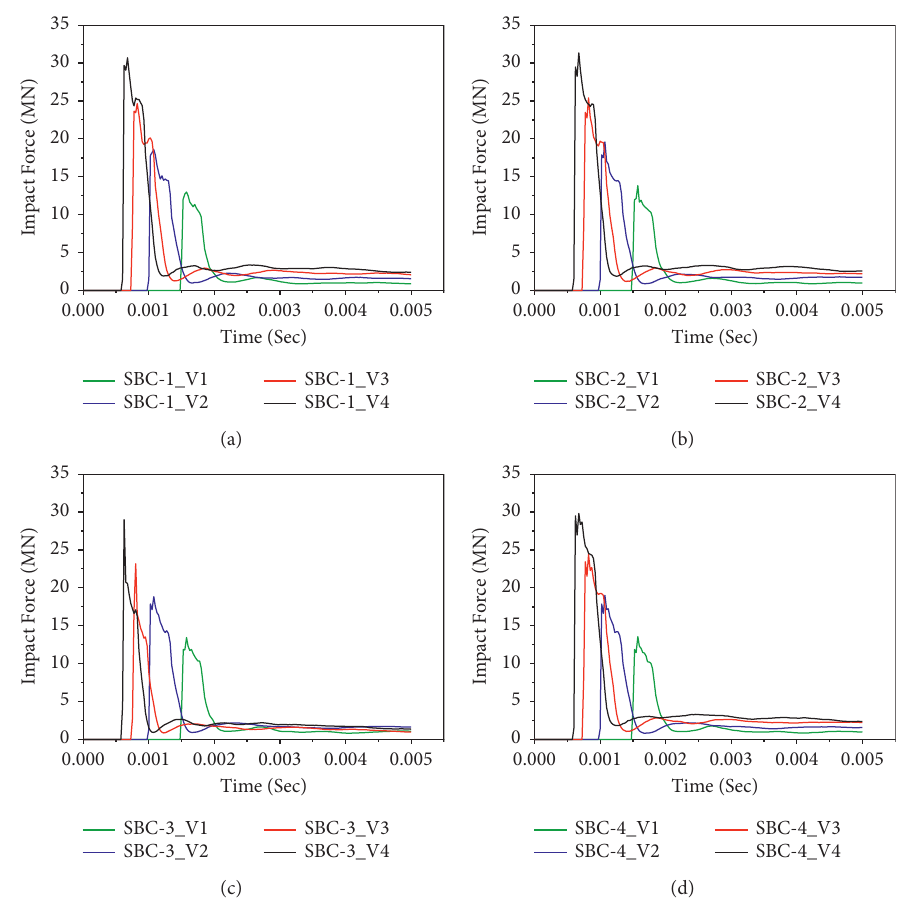
Figure 14: First impact force-time histories of CFRP confined BRC columns: (a) BC-1; (b) BC-2; (c) BC-3; (d) BC-4.